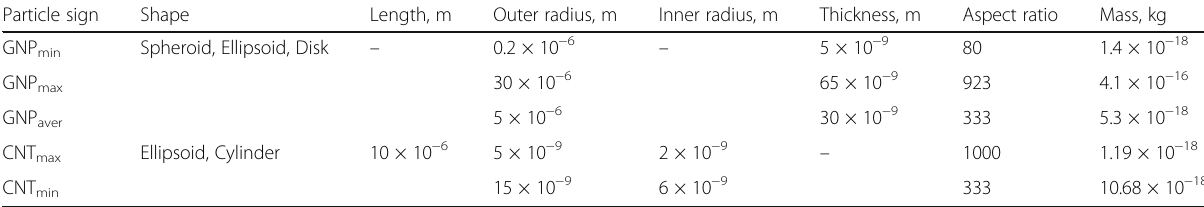
Table 1 Parameters of carbon nanoparticles Particle sign Shape Length, m Outer radius, m Inner radius, m Aspect